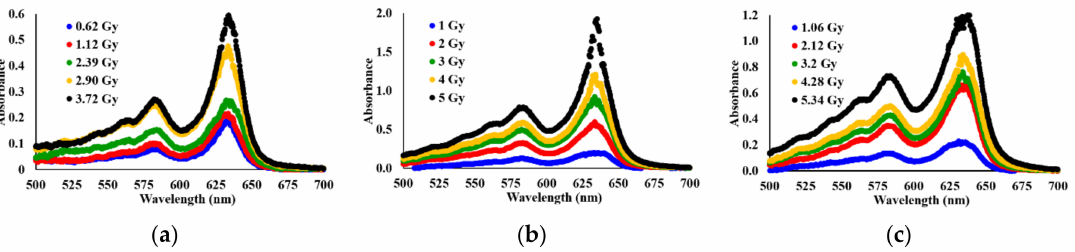
Figure 2. Visible absorbance spectra for expired EBT3 films irradiated by ( a ) 90 kVp X-rays, ( b ) 6 MV photon beam, and ( c ) 6 MeV electron